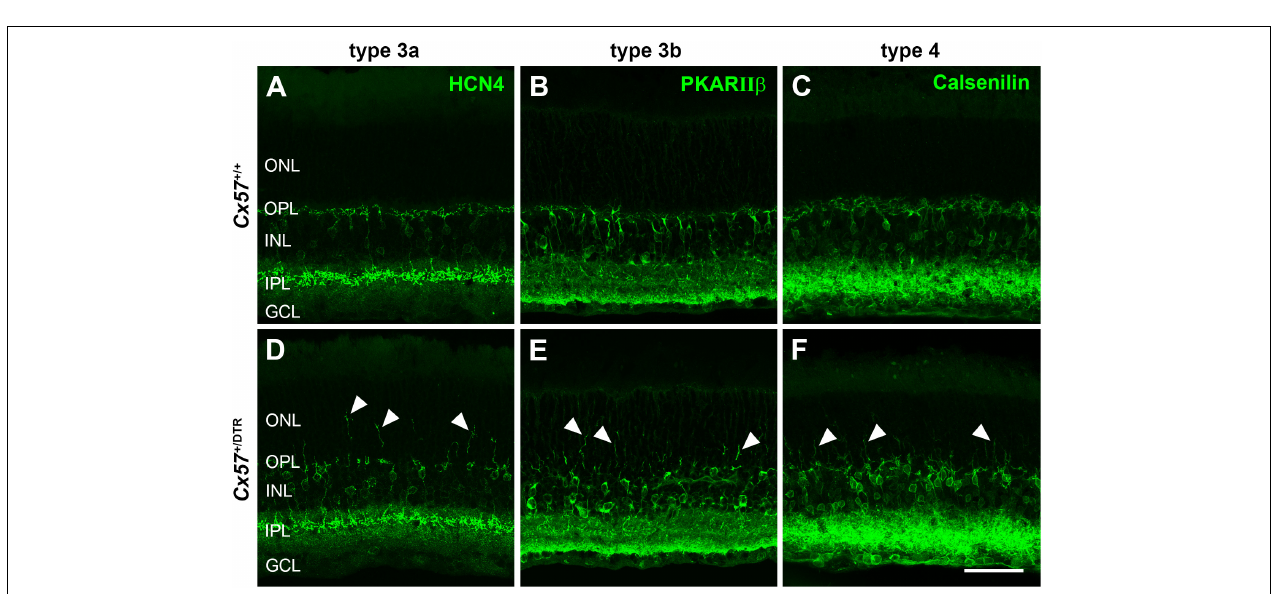
FIGURE 8 | Absence of functional synapses between cones and ON bipolar cells in adult horizontal cell-ablated mice. (A–H) Triple labeling of retinae from Cx57 + / + and Cx57 + / DTR mice (P56) for GPR179 (a component of the mGluR6 macromolecular complex, yellow), cone arrestin (a marker for cones, blue) and SCGN (a marker for a subset of ON and OFF bipolar cells, magenta). In wild-type mice, GPR179-immunoreactive puncta were observed at contact points between cone pedicles and bipolar cell dendrites (arrowheads) (A–D) . In contrast, GPR179 labeling was completely absent in Cx57 + / DTR mice (E–H) , suggesting that adult horizontal cell-ablated mice lack functional synapses between cones and ON bipolar cells. Scale bar, 10 µ m.